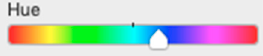
Figure 1. Hue spectrum.